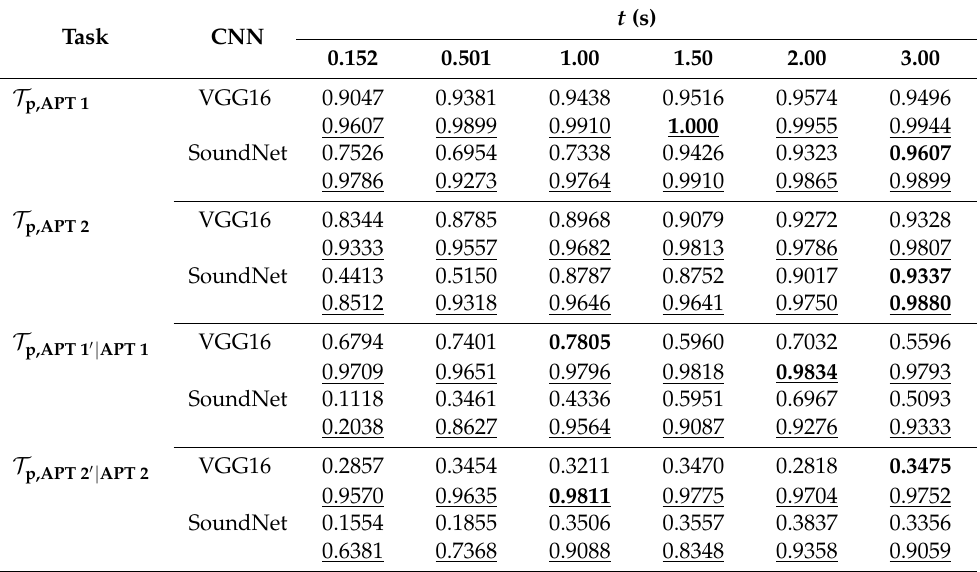
Table 4. F1 scores of the position classification tasks with t variation. The underlined values are the floor classification F1-scores obtained by rearrangement of the